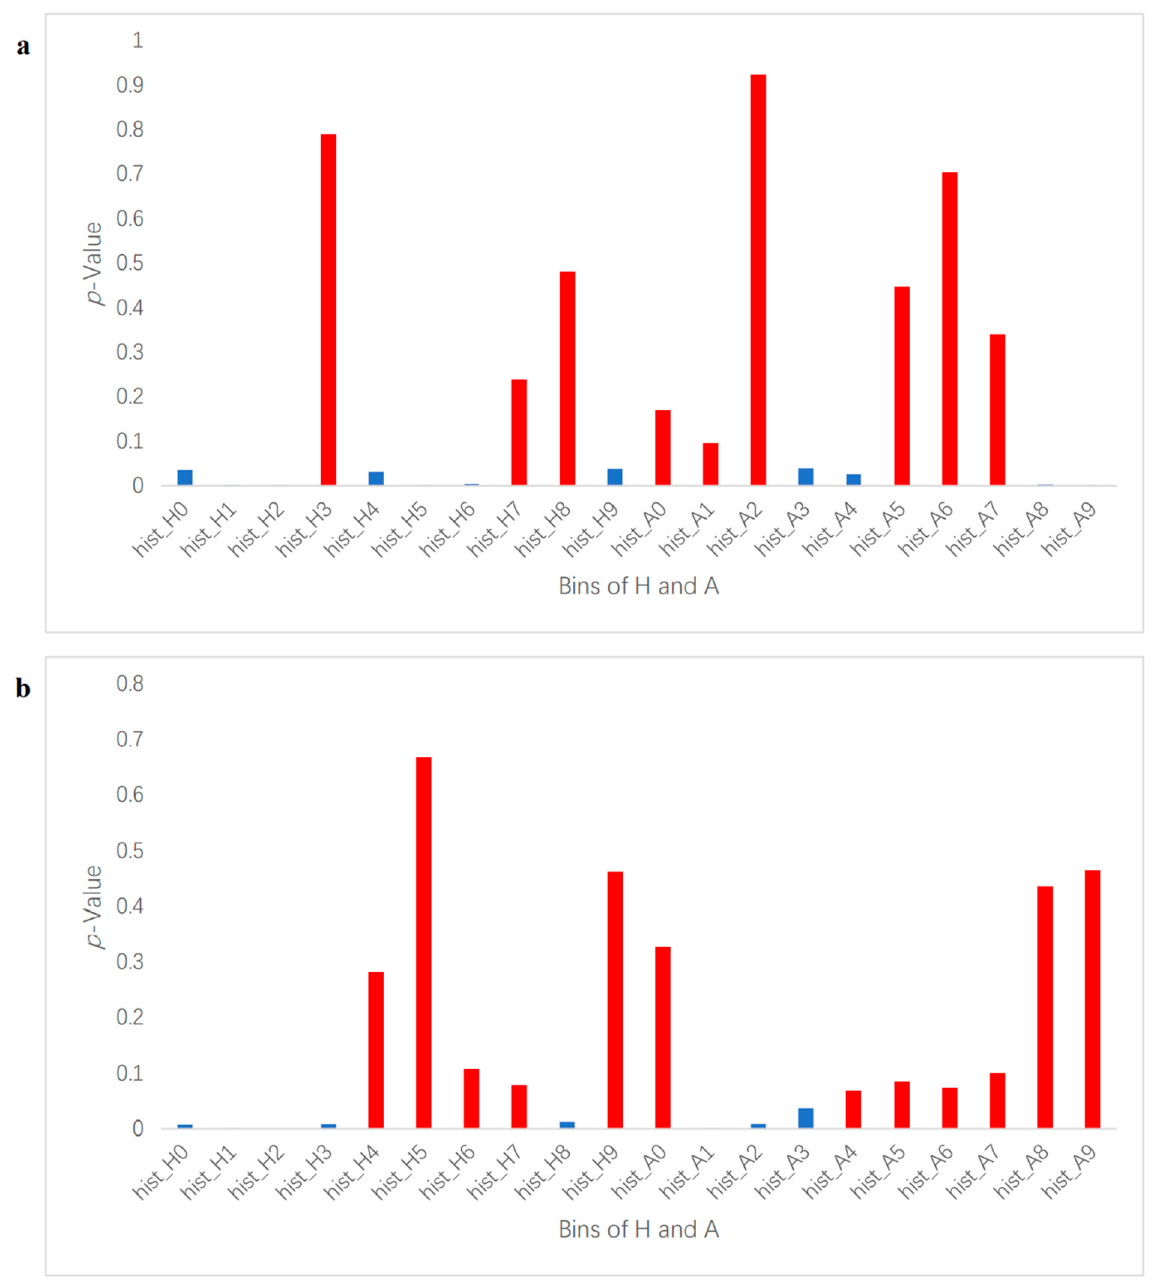
Figure 3. p -Value of histogram bins of H and A. It depicts p -value results for each histogram bin in the ROI. Hist_H represents H (hue) and hist_A represents A (greens and magentas channel). ( a ) is for 14 DAI and ( b ) is for 21 DAI. The red bars mark the bins whose p -values are over 0.05 and removed; the blue bins were kept as feature vectors for binary classification.